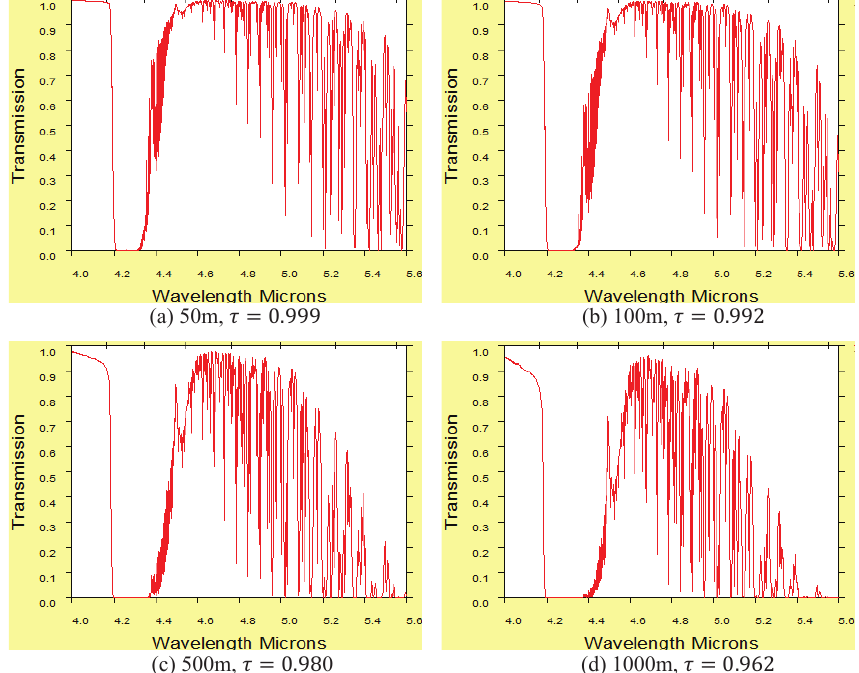
Figure 9. Atmospheric transmittance distribution, and the maximum values based on object distance.